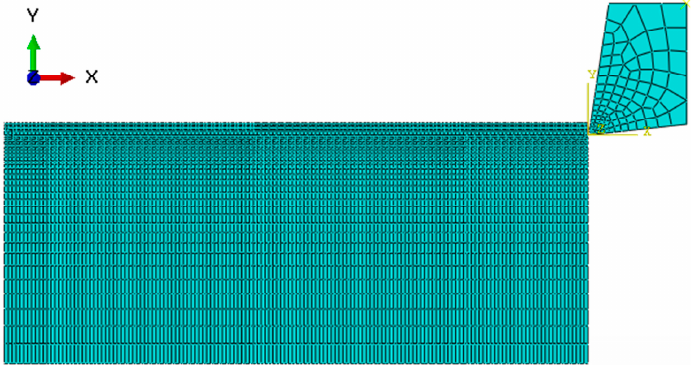
Table 2. Simulation cases and parameters. Figure 4. Orthogonal cutting simulation model. Figure 4. Orthogonal cutting simulation model. Table 1. Johnson–Cook constitutive equation parameters. Data are from [21].